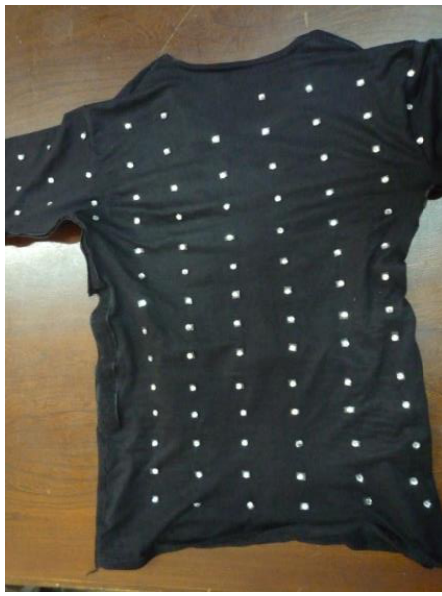
Figure 2. The arrays of spherical markers on the stretchable shirt used to determine sensor locations.